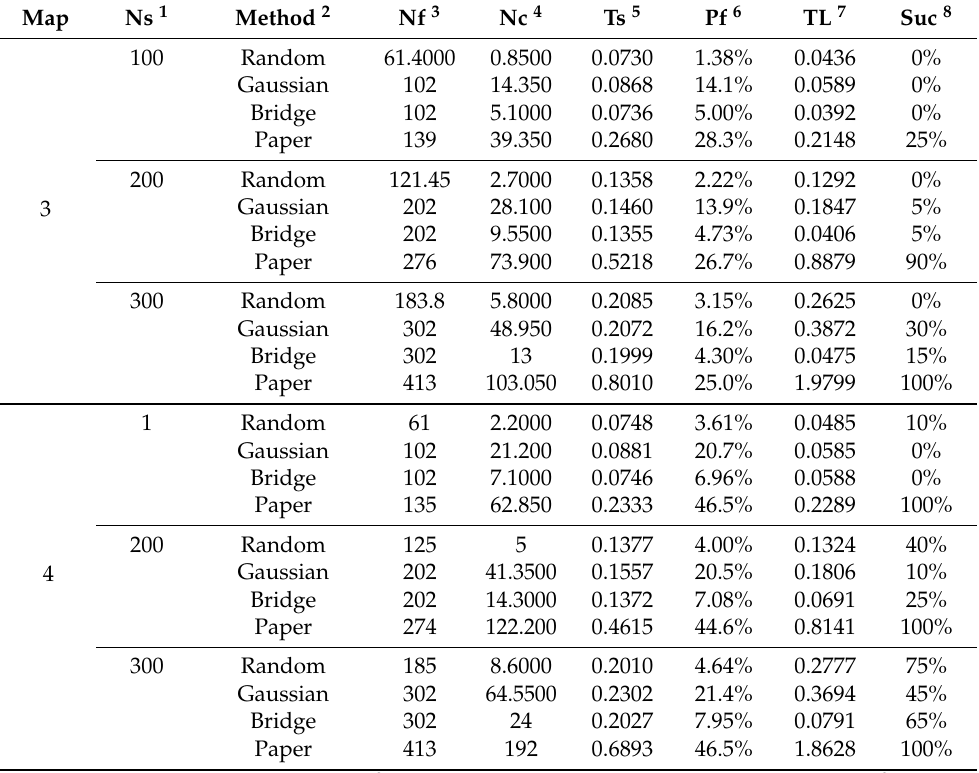
1 the mean number of all sampling points. 2 the PRM algorithm with different sampling principles. 3 the mean number of free points. 4 the mean number of the free point in the narrow channel. 5 the mean time required for completing the sampling point. 6 the mean proportion of free points in the narrow passage to the total free points. 7 the mean time required for constructing free space. 8 the success rate of path planning in 20